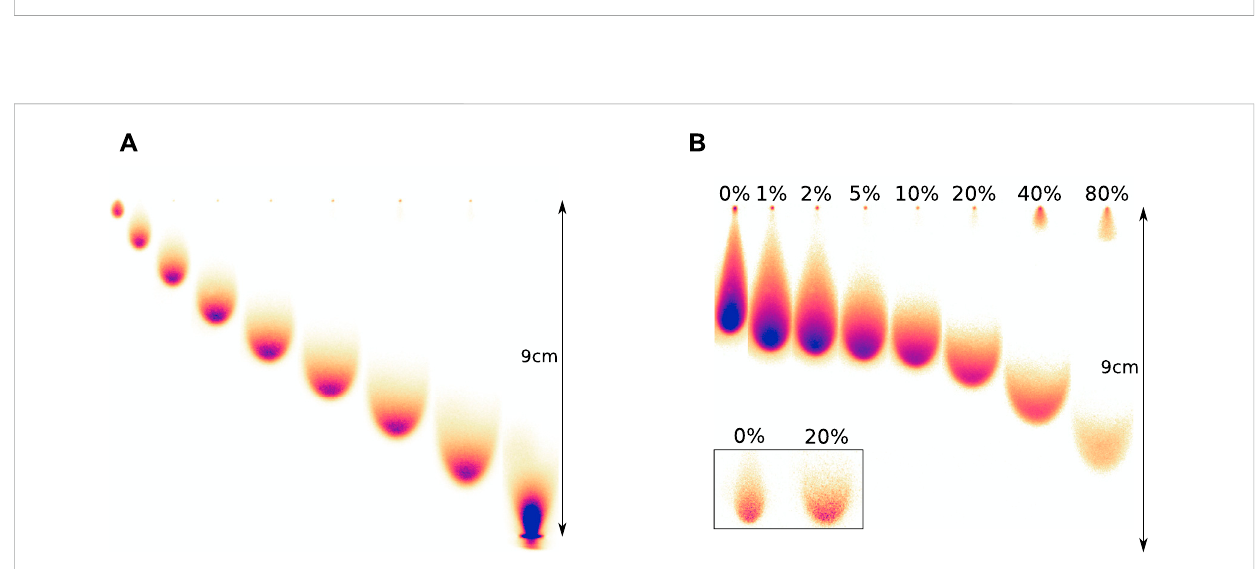
FIGURE 2 (A) False colour images with linear intensity scaling of the phase resolved downward propagation of single streamers in synthetic air at 66 mbar and 8 kV. The sidebysideexposures arecut fromtheoriginal imageto onlyshow thestreamer area. Thetime betweenimagesis20 nsand eachimagehasa 2 ns gate. (B) False colour images with logarithmic intensity scaling of streamers crossing the gap at various N 2 /O 2 ratios, where the number at the top describes the percentage of oxygen admixed to pure nitrogen. All images are taken in 66 mbar and 8 kV at identical delays related to the voltage pulse rise and all images consist out of 50 accumulations, except for the images in the inset, which depict single shots for the 0 and 20%